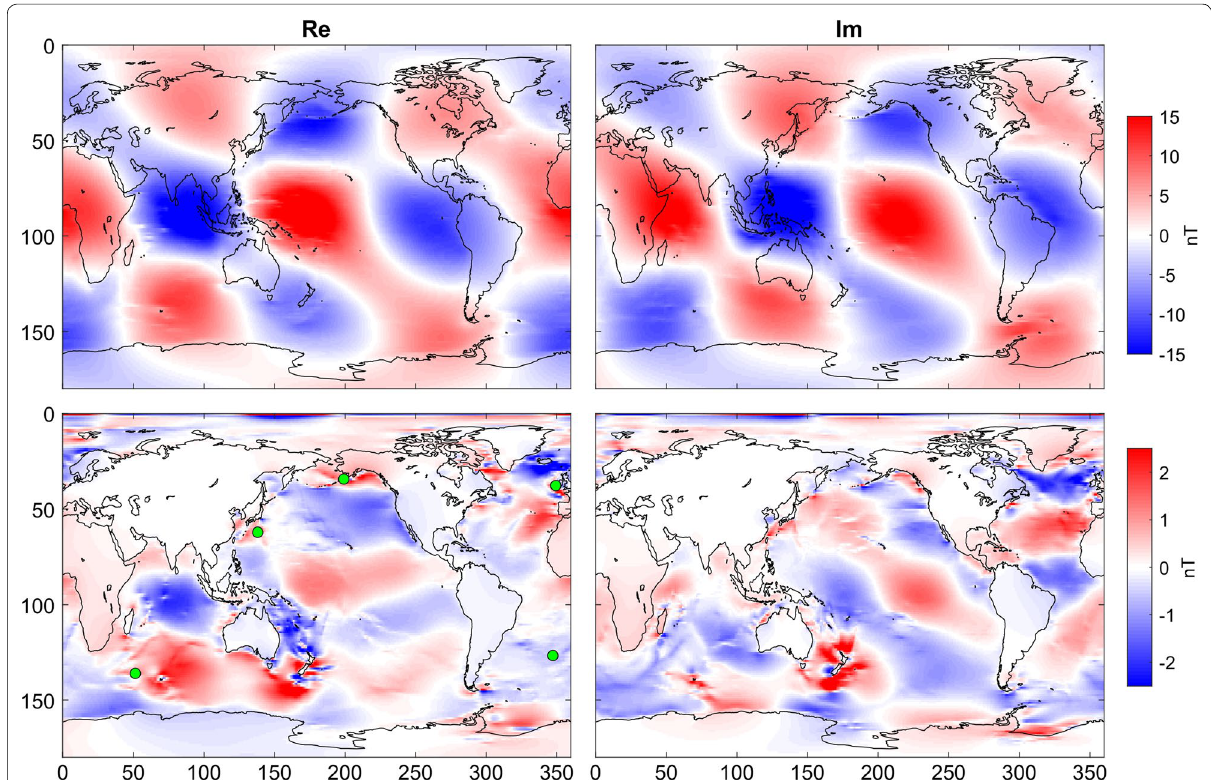
Fig. 6 Modeled X component at a period of 12 h at the surface level. Top and bottom are the Sq and tidal field, respectively. Left and right are the real and imaginary parts, respectively. Green circles denote, from left to right, CZT (Crozet Archipelago), T12-2 (Philippine Sea), SHU (Alaska), VAL (Ireland), and TDC (Tristan da Cunha). Note the different scales for top and bottom